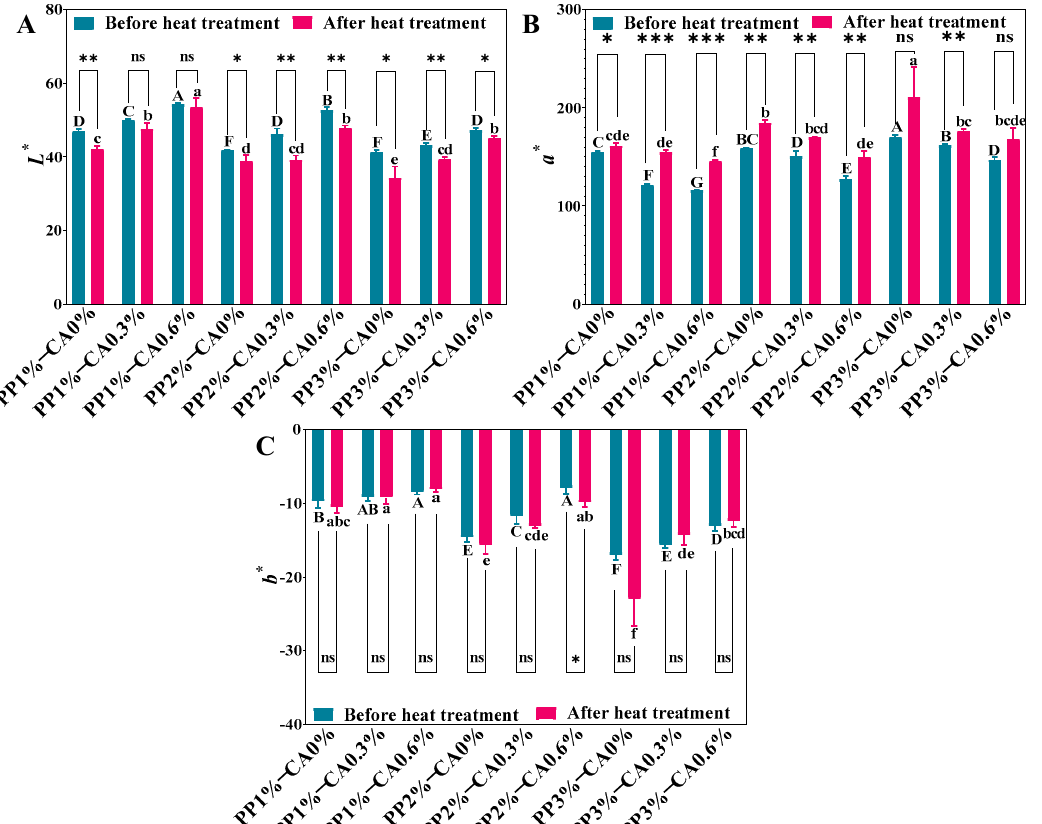
Figure 3. The colour of the restructured mackerel mince and its heat treatment product: ( A − C ) are the restructured mackerel mince’s L *, a *, b * of restructured mackerel mince before and after heat treatment. Different marked letters in each figure indicated statistically significant differences in data in the figure ( p < 0.05); the letters “A − G” represent the significance between mackerel mince before heat treatment; the letters “a − f” indicate the significance between mackerel mince after heat treatment. The asterisks (*) indicate the significant differences between the two groups before and after heat treatment at p < 0.05; the asterisks (**) indicate the signi fi cant di ff erences between the two groups before and after heat treatment at p < 0.01; the asterisks (***) indicate the signi fi cant di ff erences between the two groups before and after heat treatment at p < 0.001; the mark (ns) indicates no signi fi cant di ff erence between the two groups before and after heat treatment ( p ≥ 0.05).